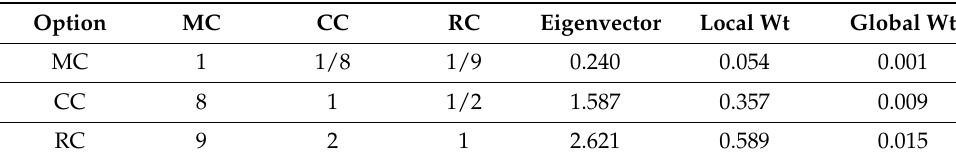
Table A11. Comparison of alternatives matrix for subcriterion SA7.